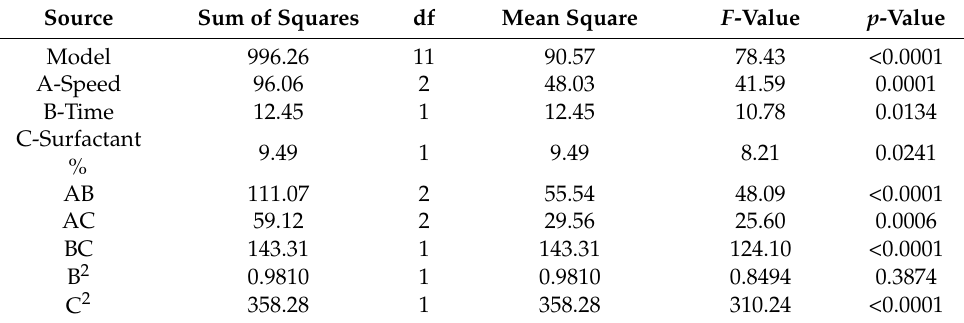
Table 4. ANOVA for zeta potential of resveratrol